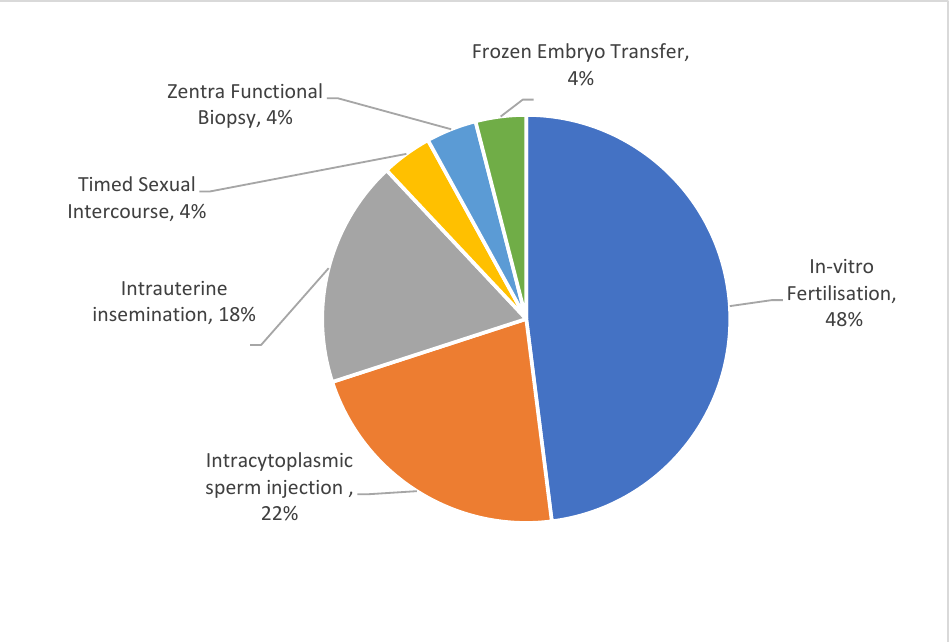
Figure 2. Types of treatments undertaken by respondents who participated in this study.